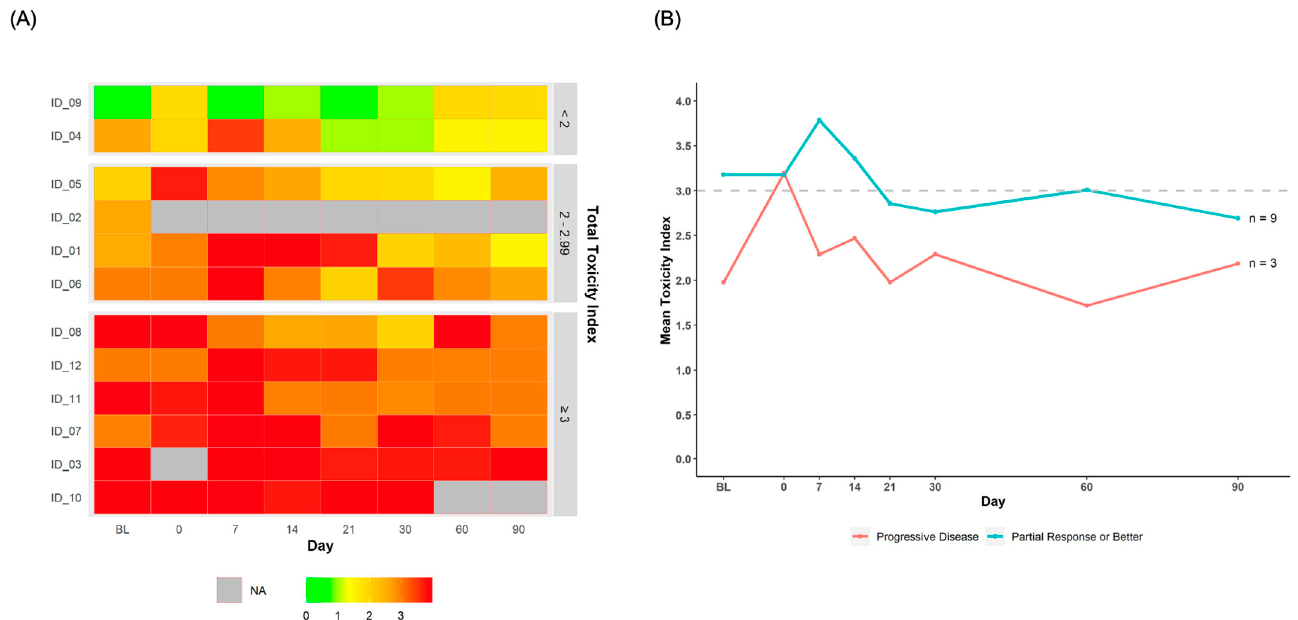
Figure 2. ( A ) Heatmap of toxicity index scores for each participant across time, listed from lowest to highest average within-person Toxicity Index. Abbreviations: BL, baseline; NA, not applicable/data missing. ( B ) Average toxicity index scores over time by participants’ treatment response at day 90 (partial response or better vs. progressive disease). The dashed grey line represents a Toxicity Index score of 3.0 so that scores can be easily identified as mild to moderate (<3.0) vs. severe ( ≥ 3.0). Abbreviations: BL, baseline.